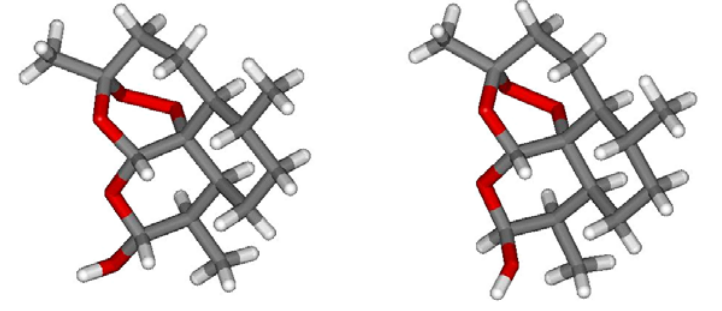
Figure 3. Polytube models of the two interconverting epimers of DHA ( 2 ): the 2 β -epimer (right) was obtained by computer editing of the X-Ray data of crystalline 2 β [10]; the model for the 2 α -epimer (left) was derived by molecular mechanics optimization (MMFF force field as implemented in SPARTAN 04) by inverting the configuration at